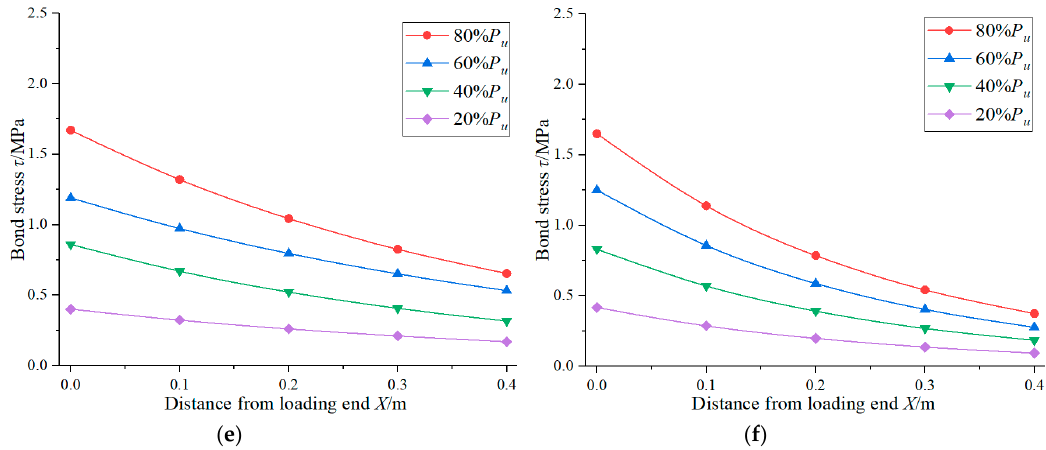
Figure 10. The distribution of bond stress based on theoretical analysis. ( a ) SRC-1; ( b ) SRC-2; ( c ) SRC-3; ( d ) SRC-4; ( e ) SRC-5; ( f ) SRC-6.